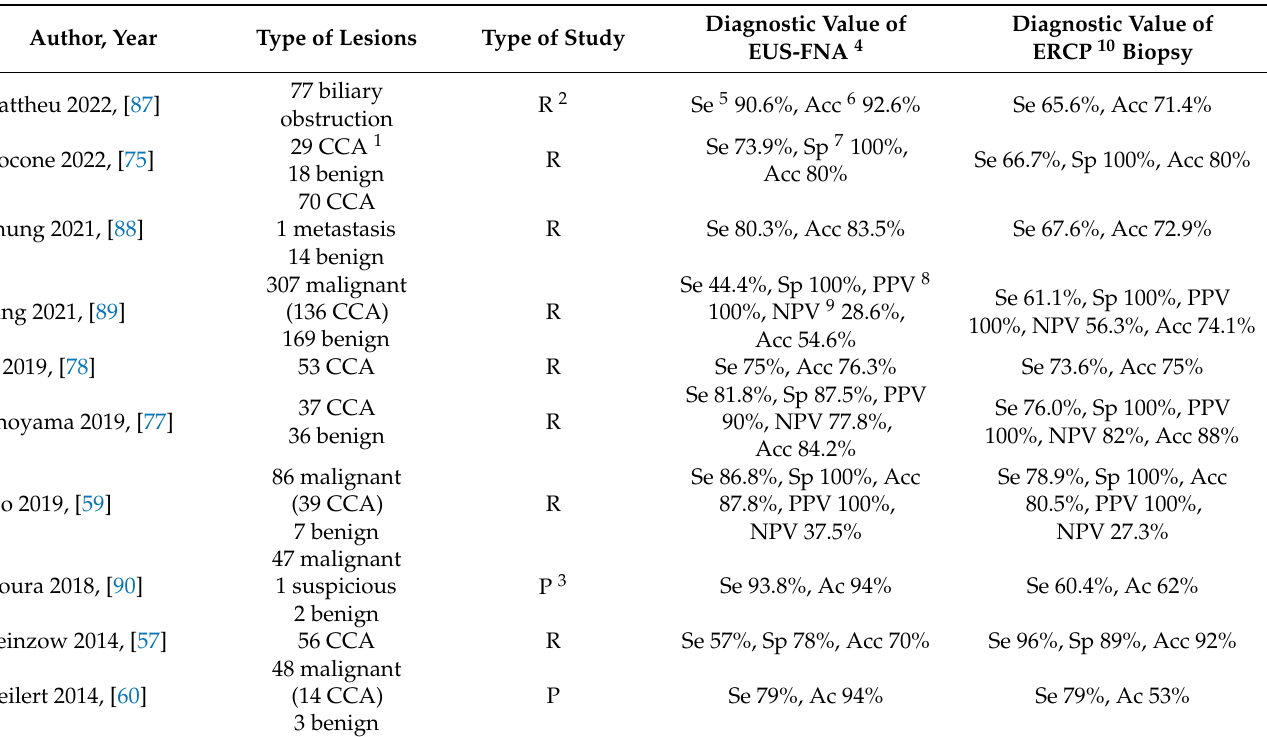
Table 4. Comparative diagnostic value of endoscopic ultrasound and ERCP tissue acquisition for biliary